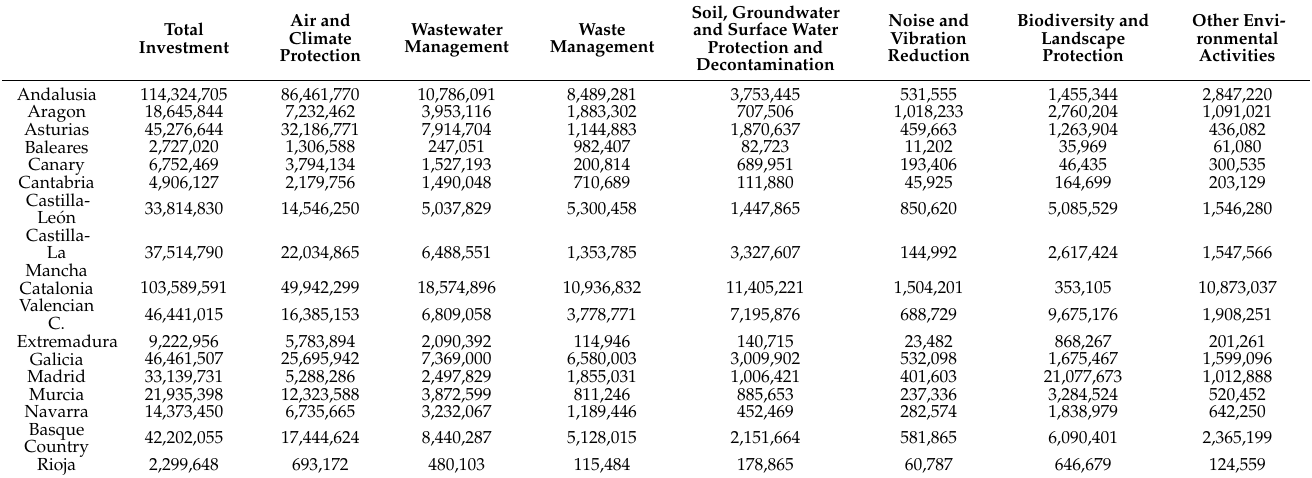
Table 11. Investments in environmental